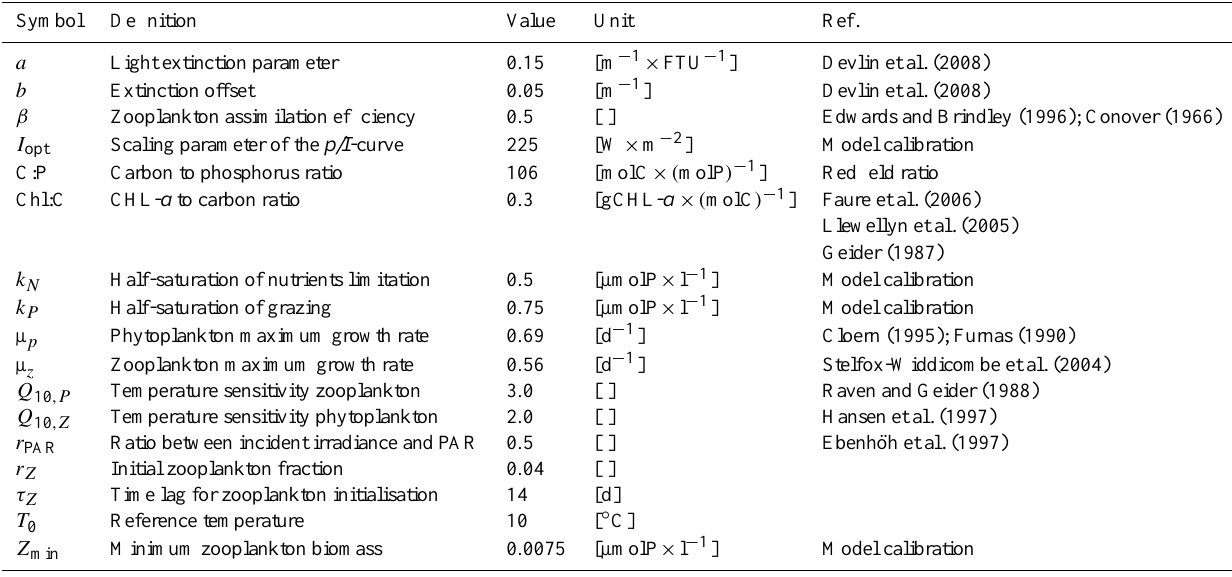
Table 1. Model parameters and their values (see also Appendix).